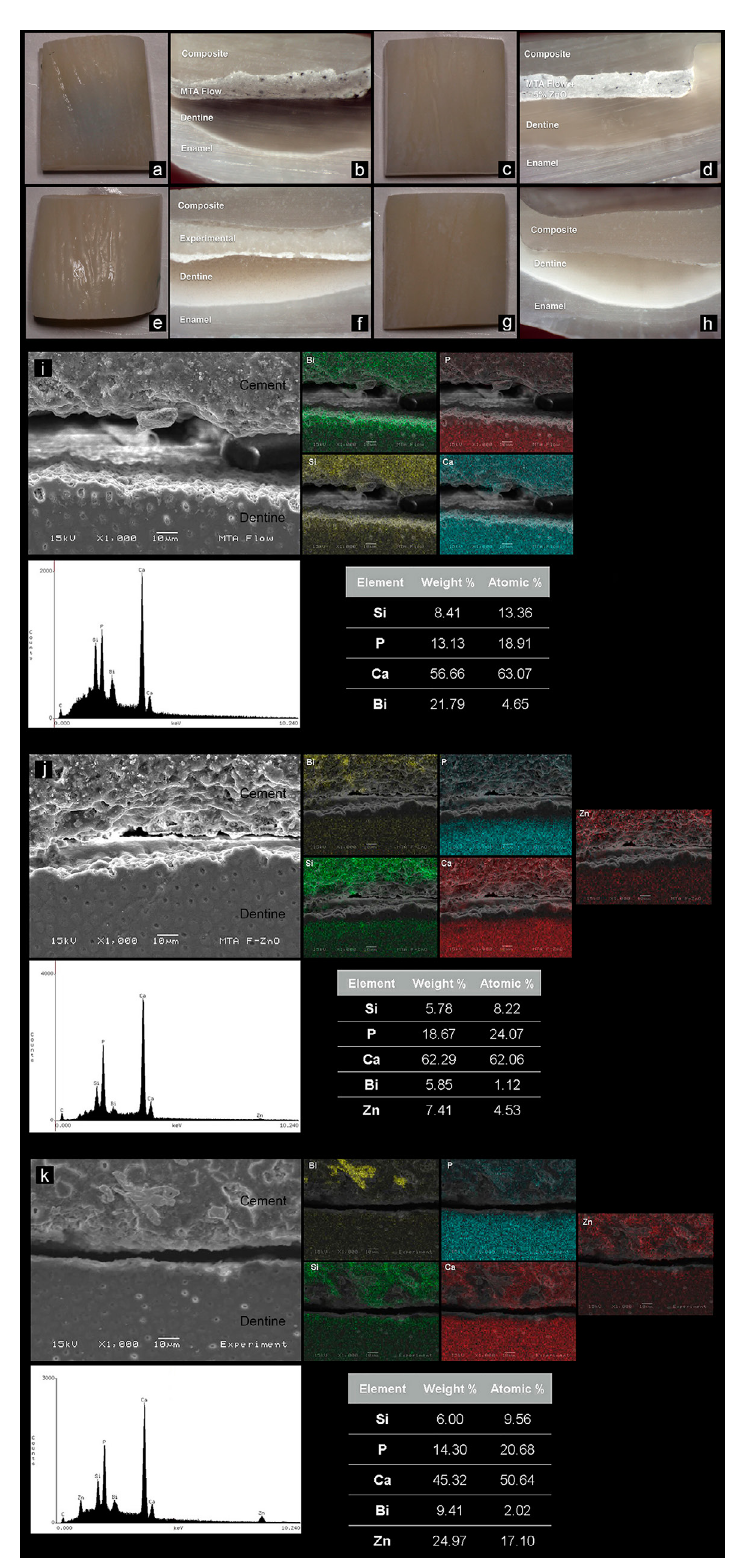
Figure 2- Representative specimens of bovine teeth filled with Grey-MTAFlow cement (a, b), Grey-MTAFlow cement + 5% ZnO (c, d), experimental cement (e, f) and negative control (g, h). Darkening is evident in Grey-MTAFlow cement. Dentine is stained, with grey color visible on the buccal surface. Stereomicroscopic images at 2x magnification. Scanning electron micrographs and energy dispersive analysis with elemental maps of sectioned teeth filled with the tested materials. Grey-MTAFlow cement (i), Grey-MTAFlow cement + 5% ZnO (j) and experimental cement (k). Calcium (Ca), silicon (Si), and phosphorus (P) were found in all specimens. Bismuth (Bi) was found in Grey-MTAFlow cement, Grey-MTAFlow cement + 5% ZnO and experimental cement corresponding to the radiopacifier. Zinc (Zn) was verified in Grey-MTAFlow cement + 5% ZnO and experimental cement corresponding to the additive. The migration of radiopacifier and Si into the dentine was evident in the elemental maps. The molecular weight of Bi was found to be high in the Grey-MTAFlow cement, with a high incidence of these ions at the cement/dentine interface. This was not verified in the Grey-MTAFlow cement + 5% ZnO, whose molecular weight of Bi was lower and ions evenly distributed in the material